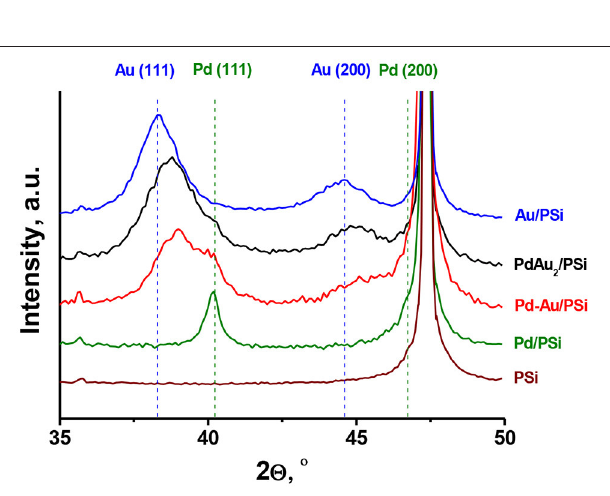
FIGURE 3 | XRD patterns of PSi support and Pd/PSi, Au/PSi, Pd-Au/PSi, and PdAu 2 /PSi catalysts.